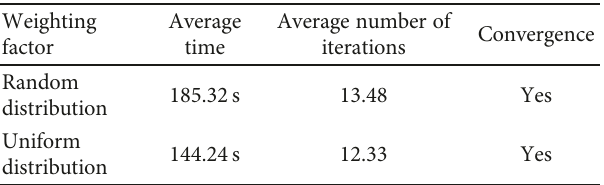
Figure 4: The Pareto optimal front of test 1 (uniform distribution). Table 1: The average calculating time and iteration information of NNSEA for solving test 1.